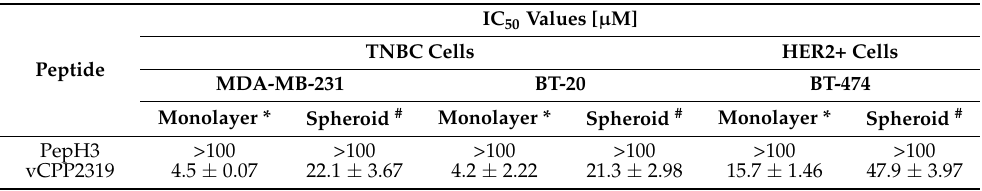
Table 2. Anticancer activity of peptides in cell monolayers and spheroids.